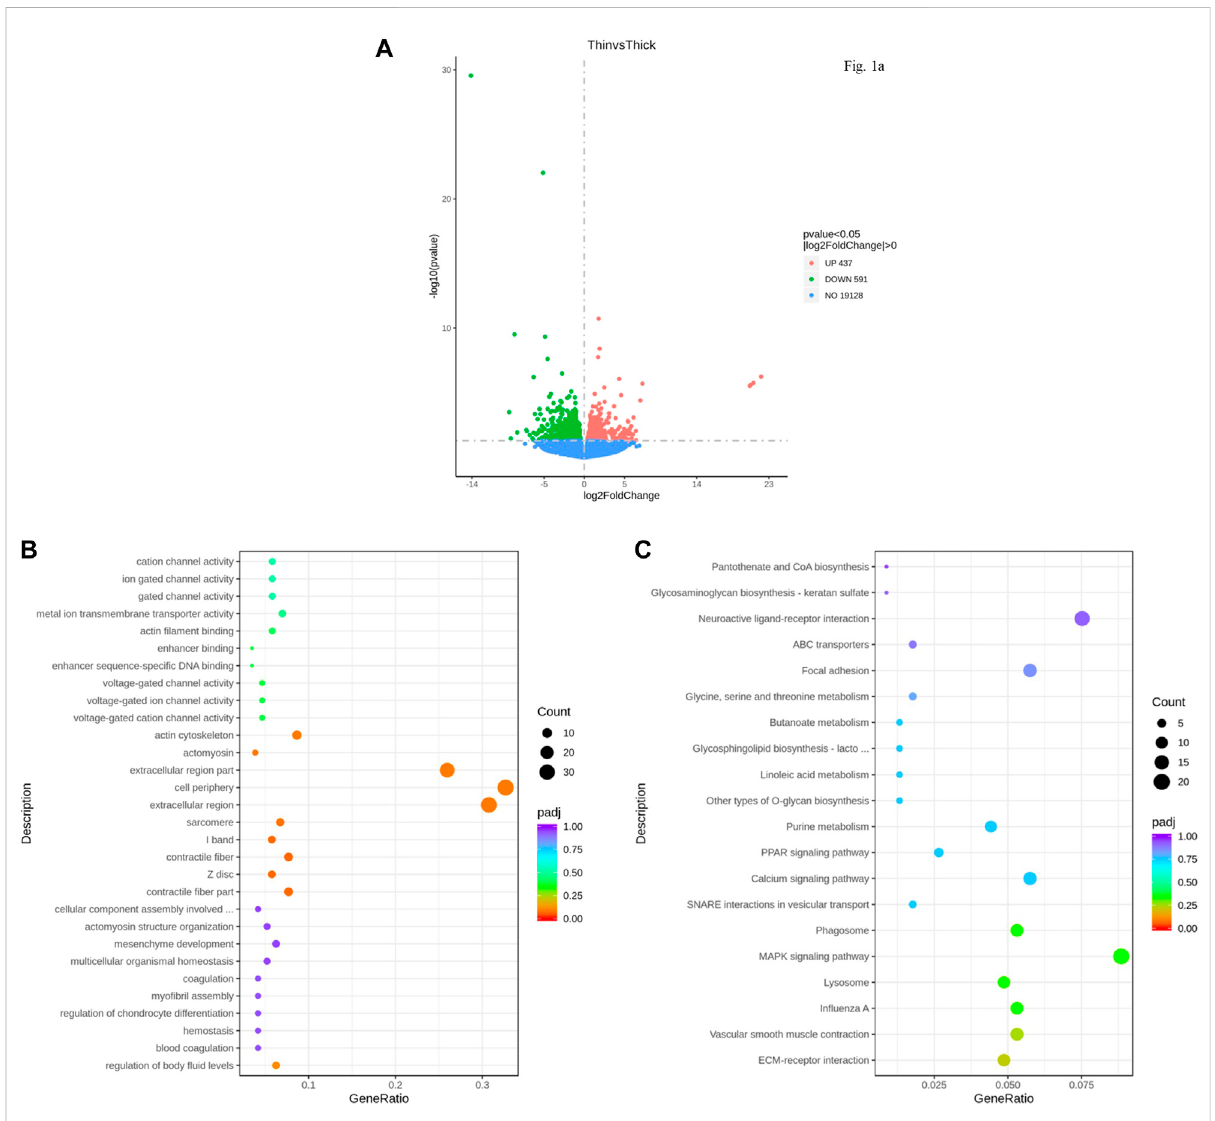
FIGURE 1 Differentially expressedgenes(DEGs)identi fi edfor theuterusbetweenHEandLEhens. (A) .VolcanoplotofDEGs between HEandLEhens; (B) . GO analysis result of DEGs between HE and LE hens; (C) . KEGG analysis result of DEGs between HE and LE